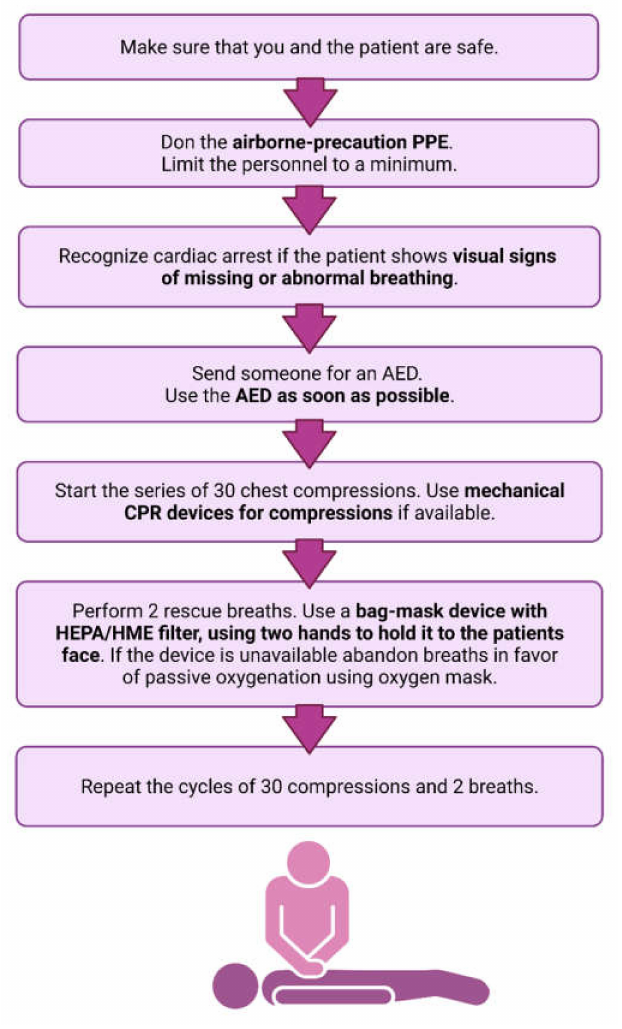
Figure 2. A summary of novel Basic Life Support recommendations. The modified recommendations are marked in